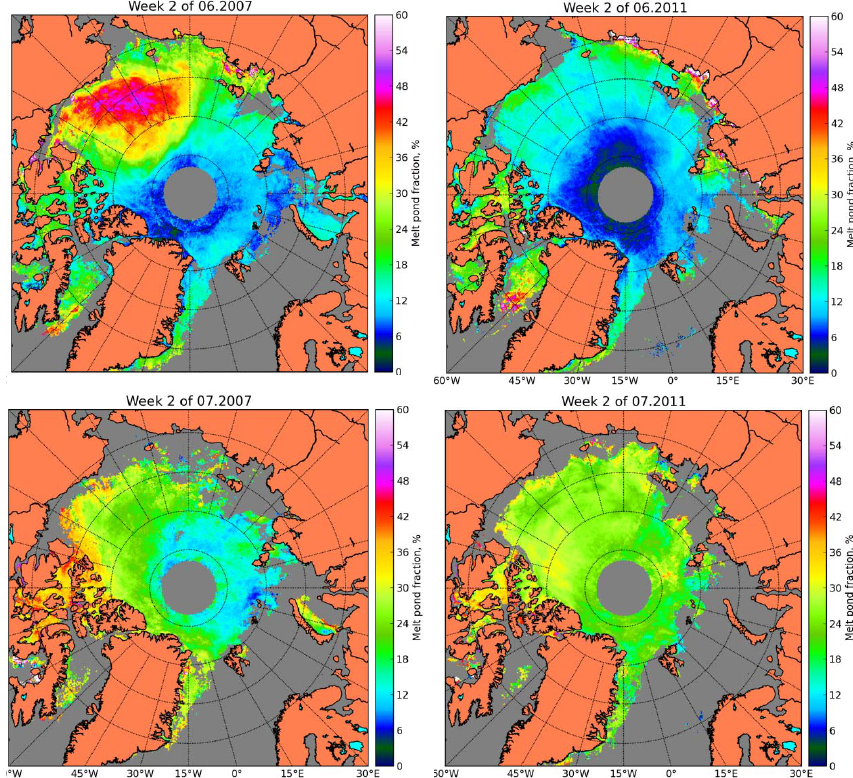
Figure 4. Main differences of weekly MPF averages 2007 and 2011 (Fig. 3). Comparison of the weekly average pond fraction for the second week of June 2007 and 2011 (top row panels, left and right correspondingly) and for the second week of July 2007 and 2011 (bottom row panels, left and right correspondingly). Note the drastic melt onset in the 2nd week of June 2007, but lower MPFs in the 2nd week of July 2007 compared to